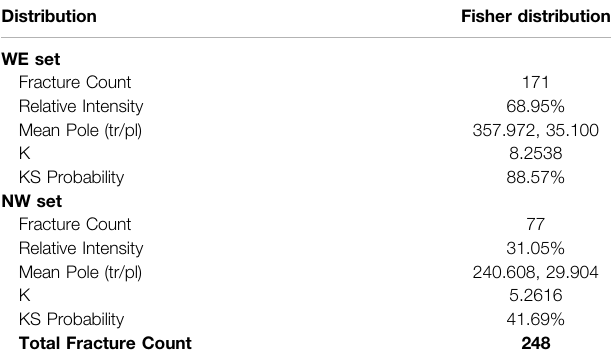
TABLE 1 | Fisher fractal statistical results for well D22.